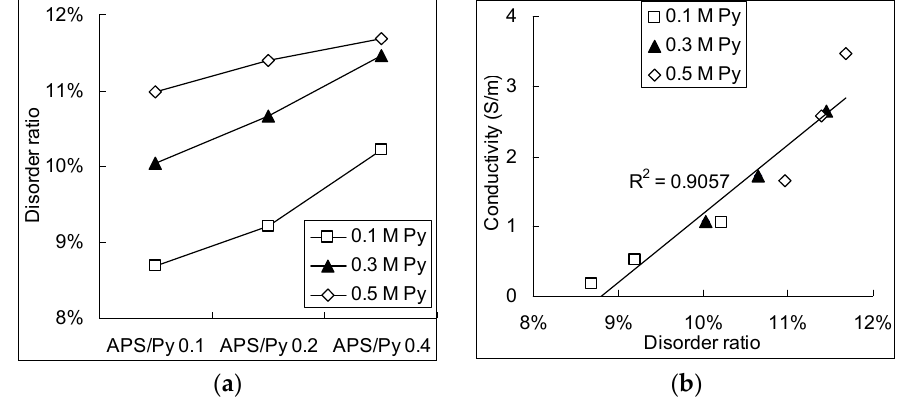
Figure 5. The chemical compositions of PPy films: ( a ) the branching ratio calculated for different APS/Py ratios in PPy films; and ( b ) the branching ratio as a function of the electrical conductivity of PPy films.